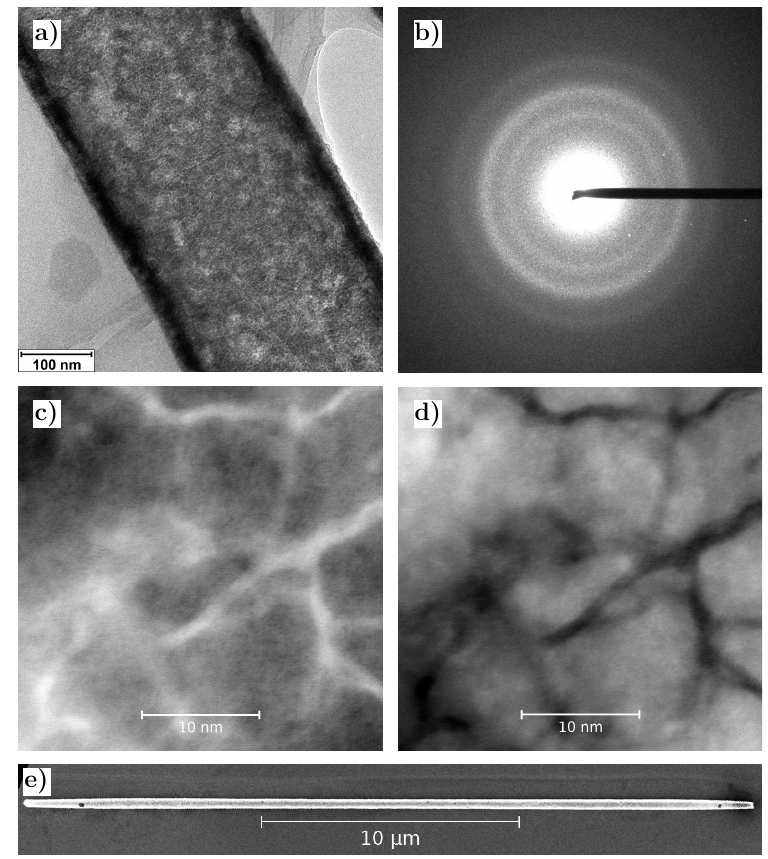
Fig. 1: Structure of electroless-deposited CoNiB nanotubes . a) Transmission elec- tron microscopy image of a nanocrystalline CoNiB tube and b) corresponding selected area (240 nm in diameter) electron diffraction pattern showing diffusive rings origi- nating from nanograins with all possible crystallographic orientations. c) Closer look on the grains with scanning transmission electron microscopy in bright and d) dark field (Z contrast, heavier elements appear brighter). e) Scanning electron microscopy image of a whole